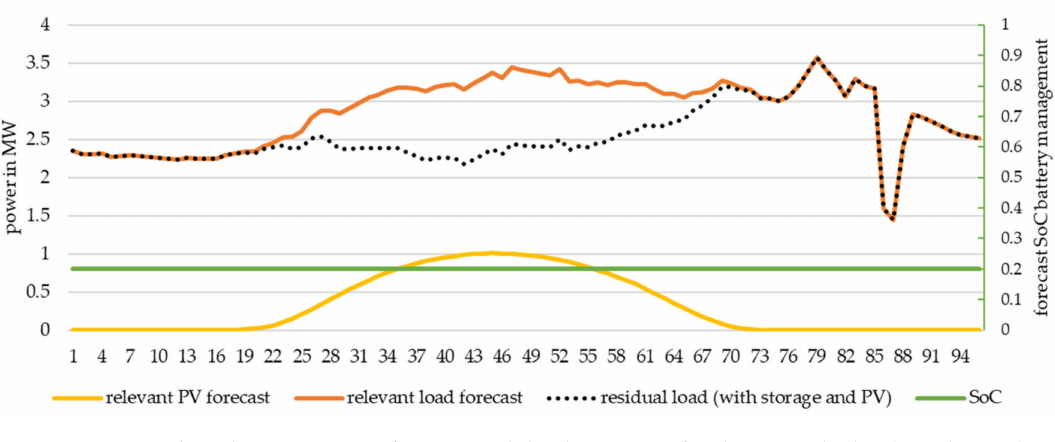
Figure 9. Resulting battery storage forecast with load concept 2 for the example day (17 July 2019), TSO substation Dresden Süd: relevant load before storage (orange), the relevant PV forecast (yellow), battery SoC over a day (green, as a percentage), and the residual load (dashed